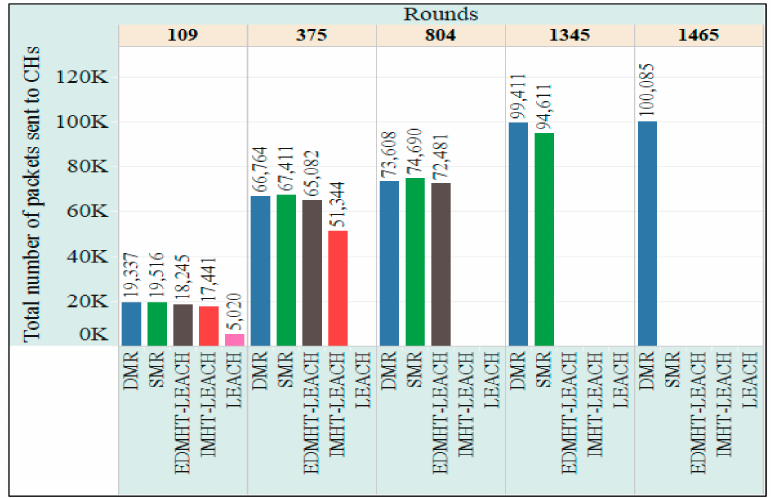
Figure 13. The total number of packets sent to CHs in the DMR, SMR, EDMHT-LEACH, IMHT-LEACH and conventional LEACH approaches versus the rounds.